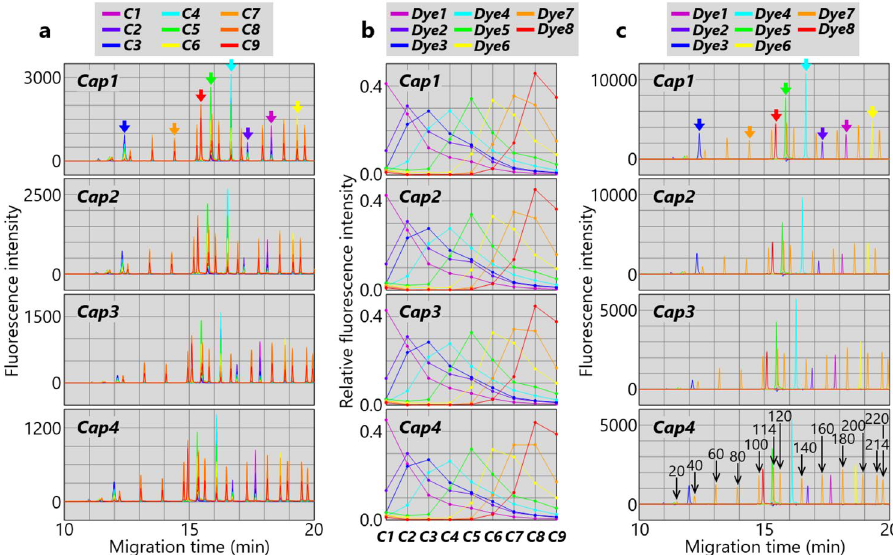
Figure 7. Simultaneous eight-dye quantification by nine-color spectrometer used for four-capillary-array electrophoresis. ( a ) Nine-color ( C1 − C9 ) electropherogram for each capillary. Eight peaks indicated by arrows for Cap1 show individual fluorescence emission of eight dyes ( Dye1 − Dye8 ). Colors of the arrows correspond to those in ( b ) and ( c ). ( b ) Fluorescence spectra of eight dyes ( Dye1 − Dye8 ) for each capillary. c Eight-dye ( Dye1 − Dye8 ) electropherogram for each capillary. Peaks of Dye7 -labeled DNA fragments are indicated by arrows with their base lengths for Cap4